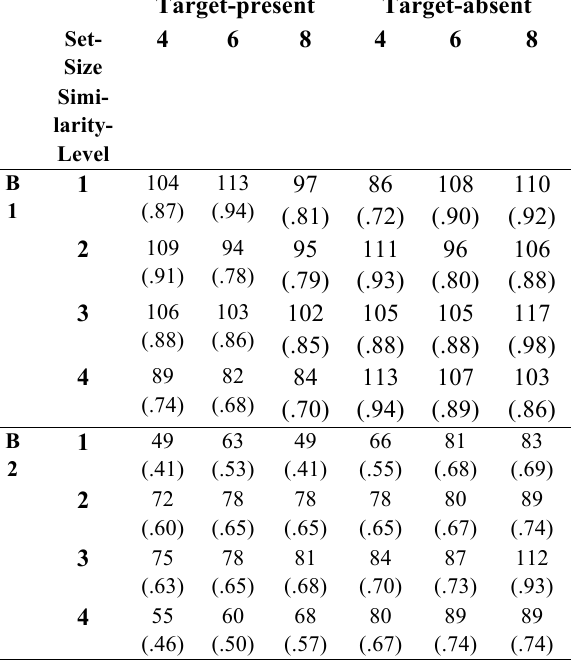
Absolute (and relative) frequencies of trials remaining after exclusion of error trials and trials without initial central fixation (summed across subjects). B2. Trials remaining for analysis of saccade amplitude and fixation duration (see text) (summed across